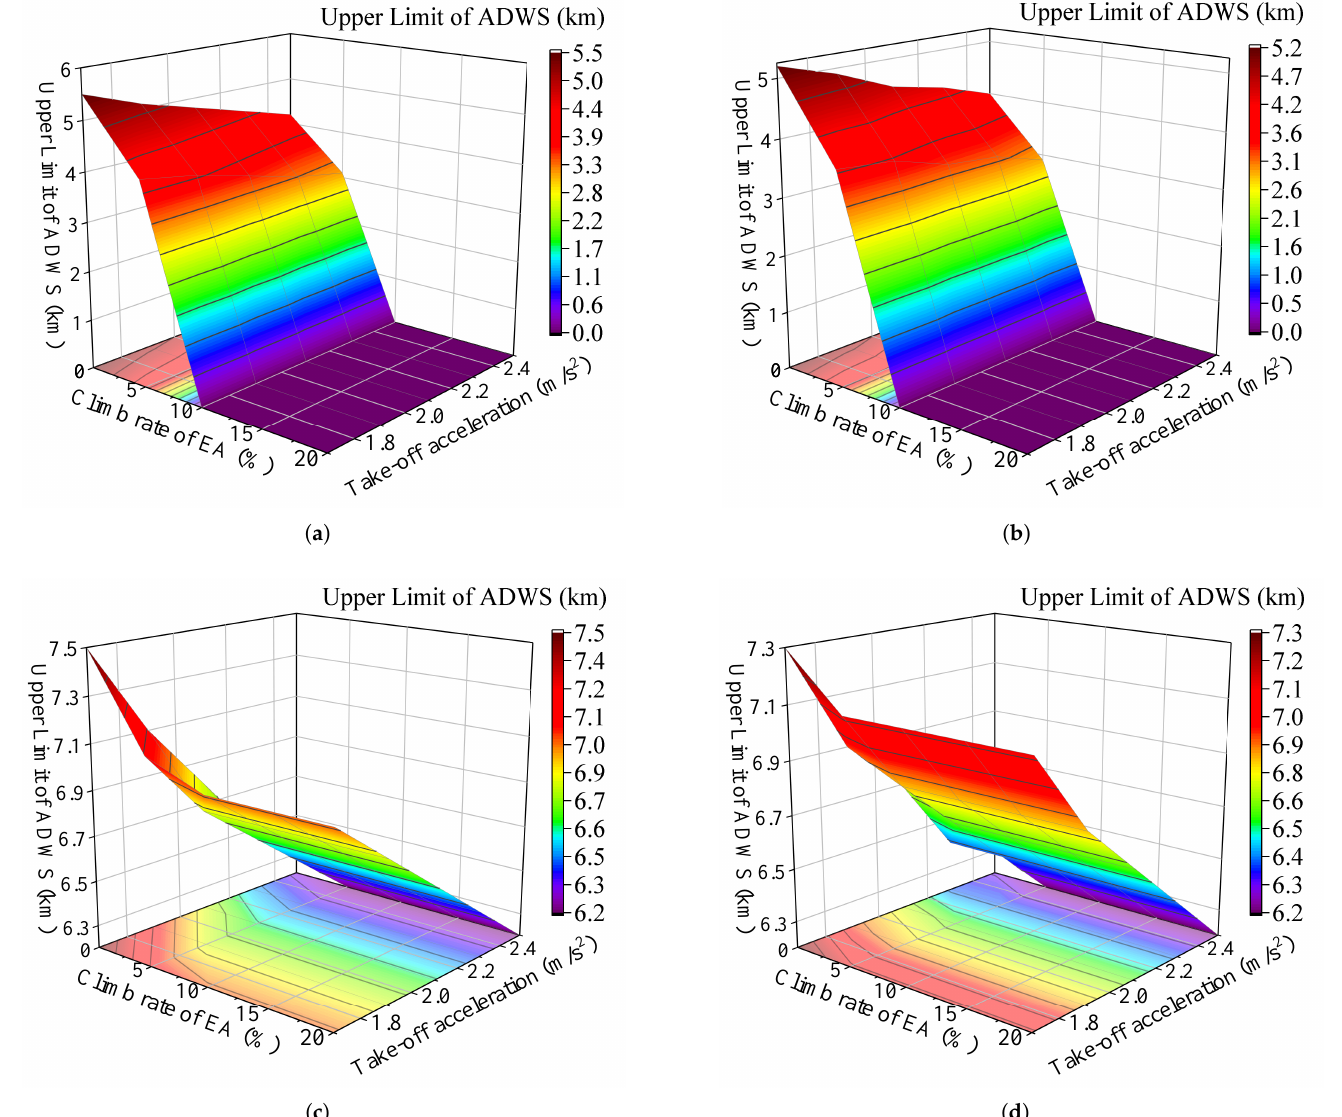
Figure 15. Results of the upper limit of the arrival and departure window separation (ADWS). ( a ) The EA maximum speed limit was 230 kt (118.3 m/s), and PKX was running northward. ( b ) The EA maximum speed limit was 200 kt (102.9 m/s), and PKX was running northward. ( c ) The EA maximum speed limit was 230 kt (118.3 m/s), and PKX was running southward. ( d ) The EA maximum speed limit was 200 kt (102.9 m/s), and PKX was running